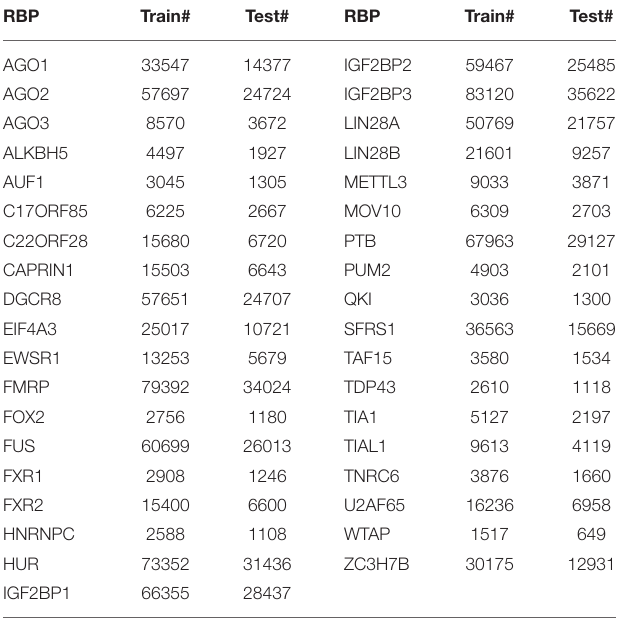
TABLE 1 | Experimental